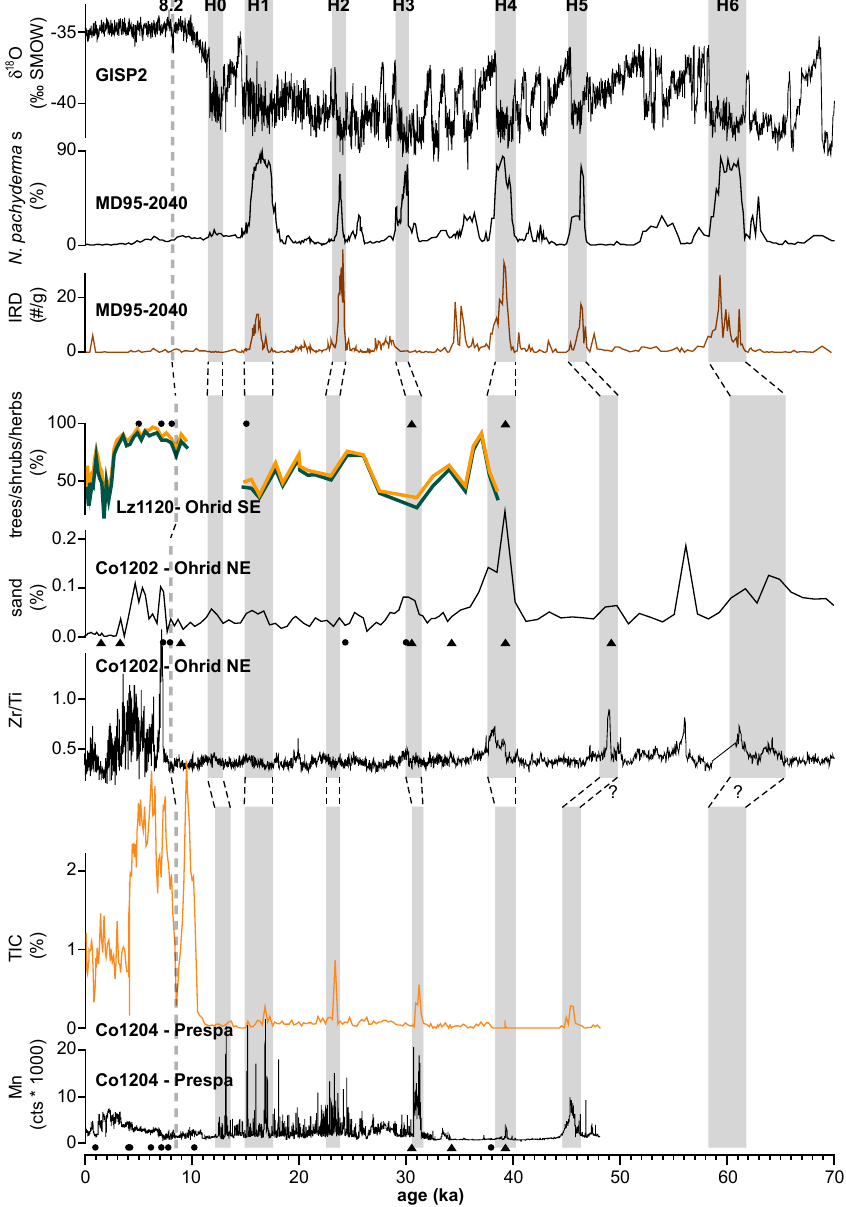
Fig. 5. Palaeoenvironmental records from Lake Prespa (core Co1204) and Lake Ohrid (cores Lz1120 and Co1202; Wagner et al., 2009; Vogel et al., 2010a) compared with the number of IRD grains and the cold water thriving foraminifera N. pachyderma from the western Iberian margin (Fig. 1; MD95-2040; de Abreu et al., 2003) and with the δ 18 O record from the GISP2 ice core (Grootes et al., 1993). Black dots and triangles in the cores from lakes Prespa and Ohrid indicate horizons, which were used for radiocarbon dating and tephrochronology. The timing and thickness of Heinrich events H1–H6 is according to de Abreu et al. (2003). occurrence of the cold water thriving foraminifera N.